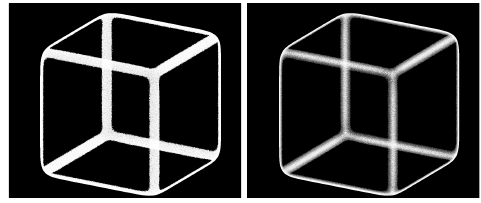
Figure 7. Comparison of the visualization results of using the functions of type (a) (left) and type (c) (right).